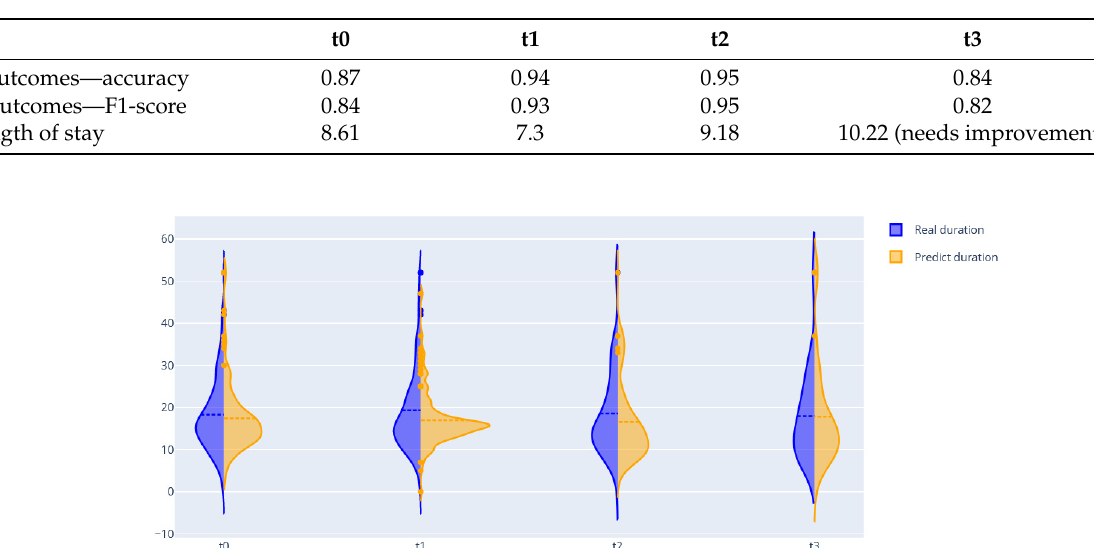
Table 5. Metrics of BN models.